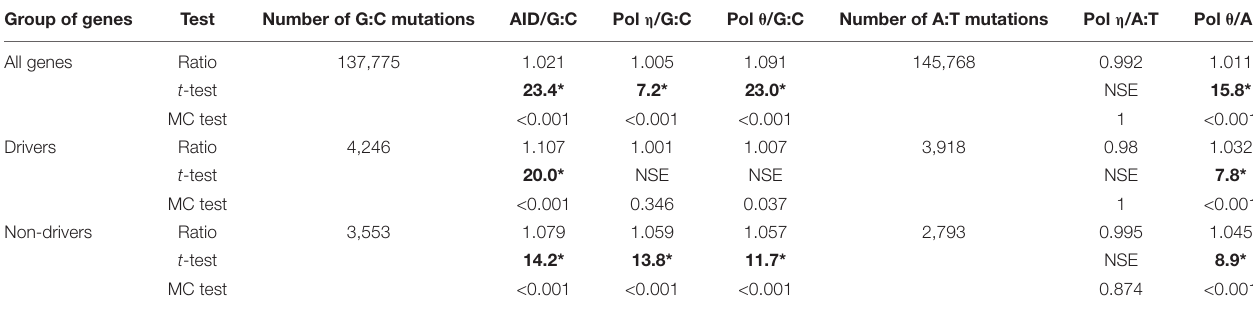
TABLE 2 | Correlation between mutable motifs and the sequence context of somatic mutations in driver and non-driver genes. Group of genes Test Number of G:C mutations AID/G:C Pol η /G:C Pol θ /G:C Number of A:T mutations Pol η /A:T Pol θ /A:T All genes Ratio